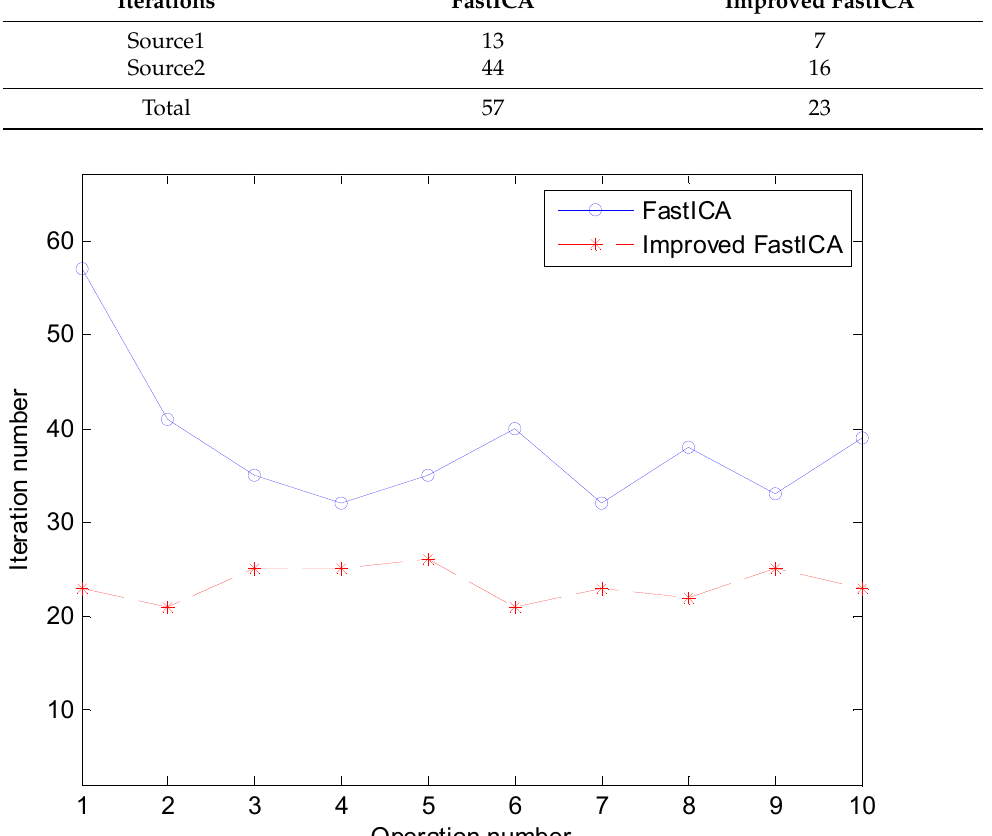
Figure 10. Iteration number under 10 runs using FastICA and improved FastICA.